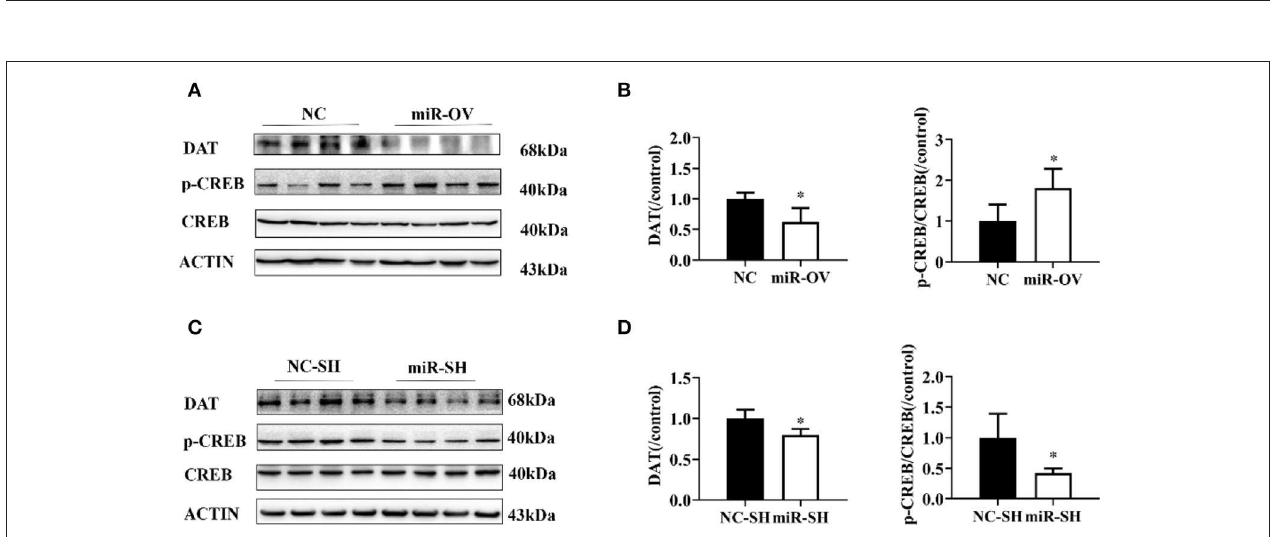
FIGURE 5 | Changes in DAT protein levels and p-CREB/CREB ratio following overexpression or suppression of miR-384-5p. (A,B) Relative levels of DAT protein and p-CREB/CREB ratio in the PFC, following overexpression miR-384-5p. (C,D) DAT protein expression level and CREB/p-CREB ratio in the PFC, following suppression of miR-384-5p. * P <